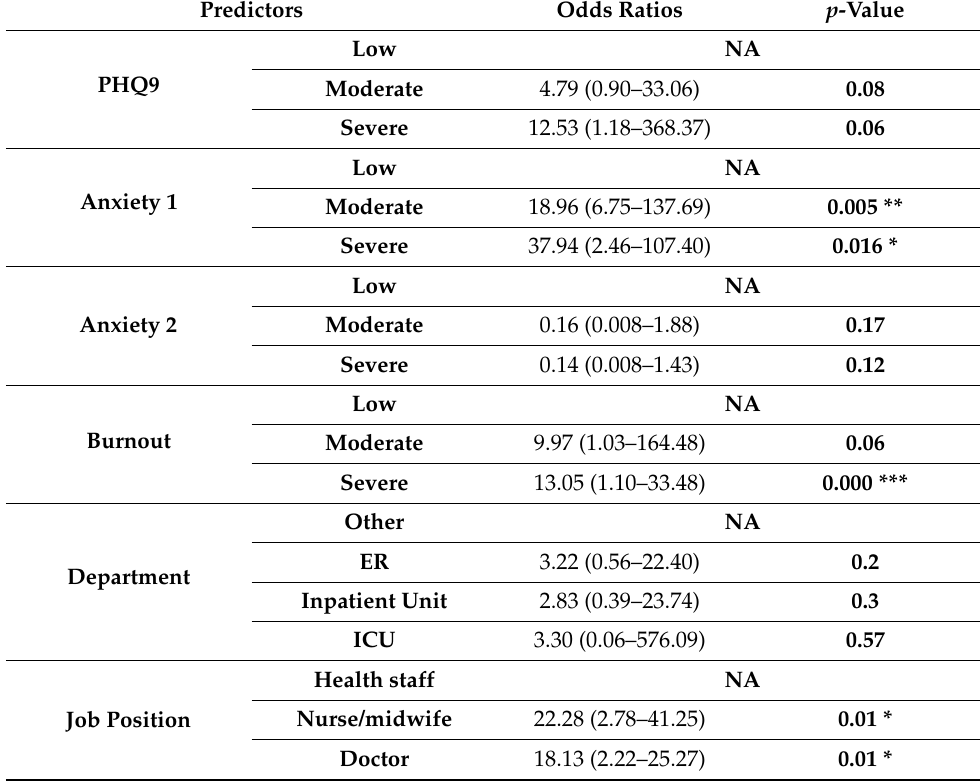
Table 3. Results of the multivariable logistic regression of the intention to leave